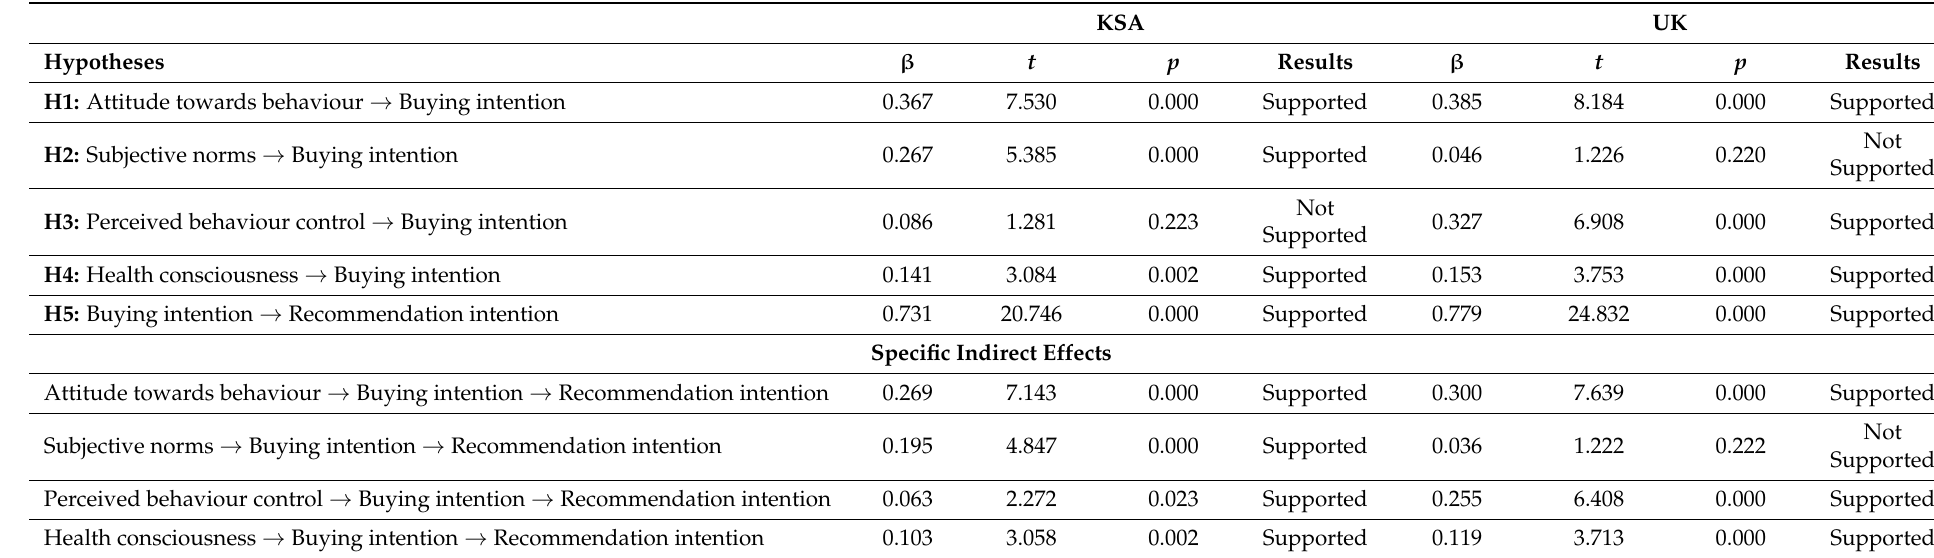
Table 5. Hypotheses testing